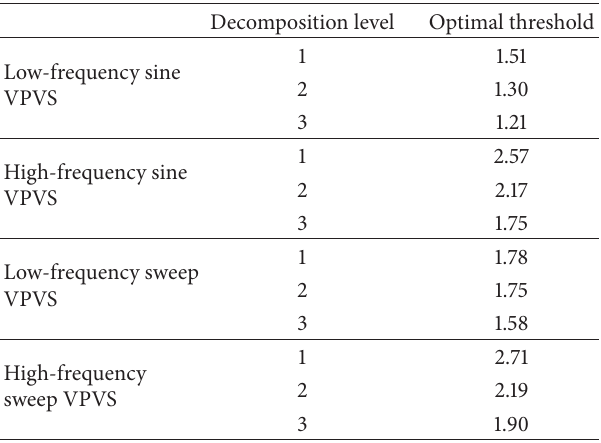
Table 1: The optimal threshold in proposed thresholding